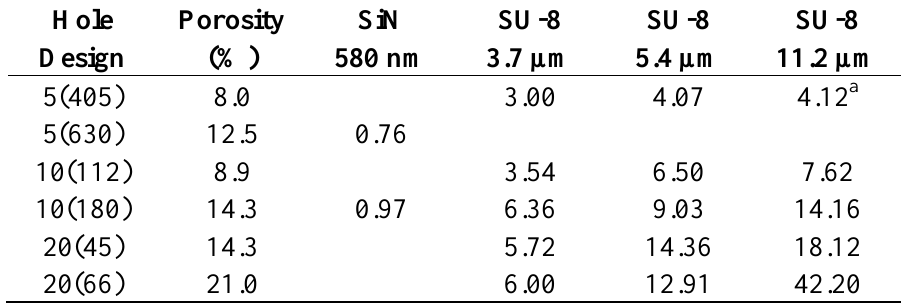
Table 3. Flow rate detection limit (nL/min) of the developed flow meters depending on material, thickness and sensor